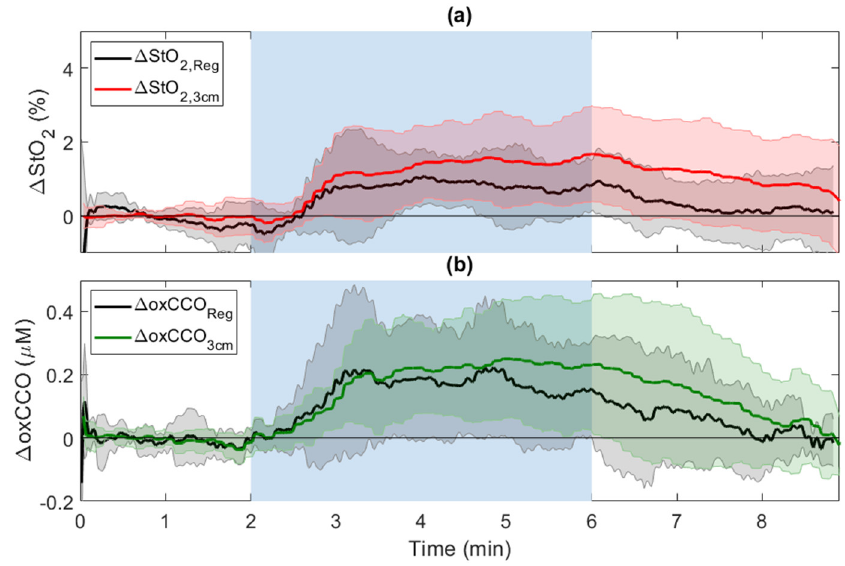
Figure 8. Regression analysis of ( a ) ΔStO 2 and ( b ) oxCCO 3cm in response to hypercapnia (blue-shaded region).